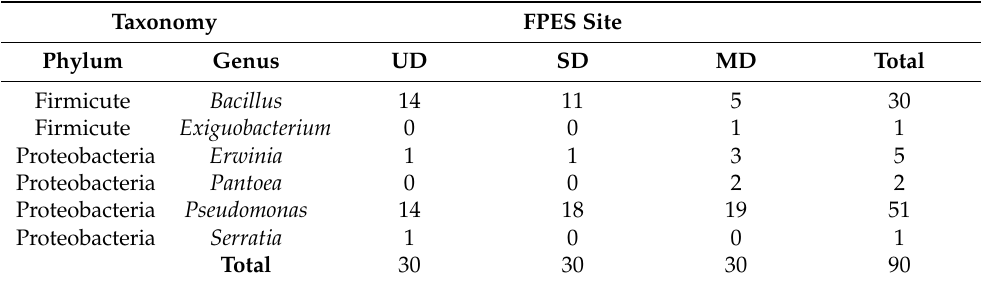
Table 1. Number of isolates within each phylum and genus by Fairbanks Permafrost Experiment Station (FPES)